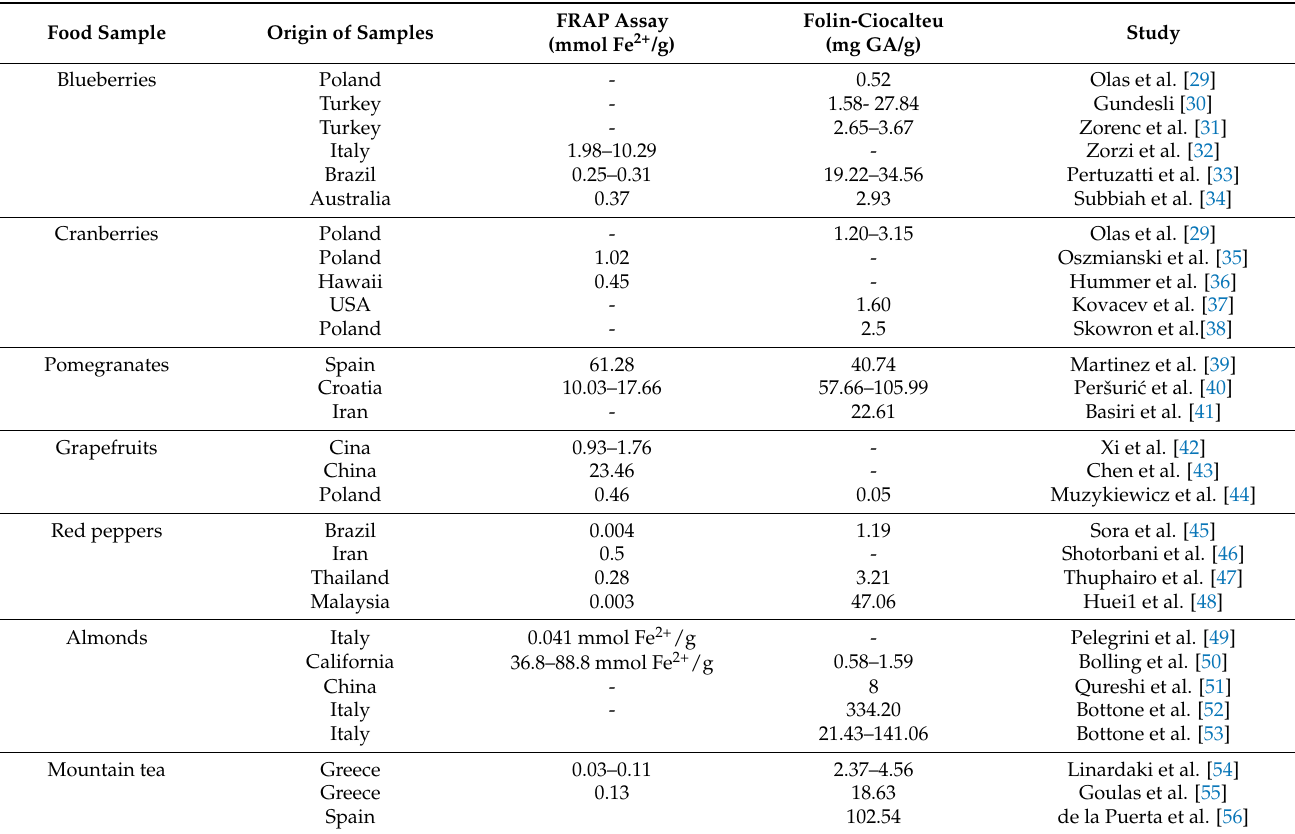
Table 1. Mean concentrations of total phenolic content and total antioxidant activity of blueberries, cranberries, pomegranates, grapefruits, red peppers, almonds, and mountain tea reported in literature.